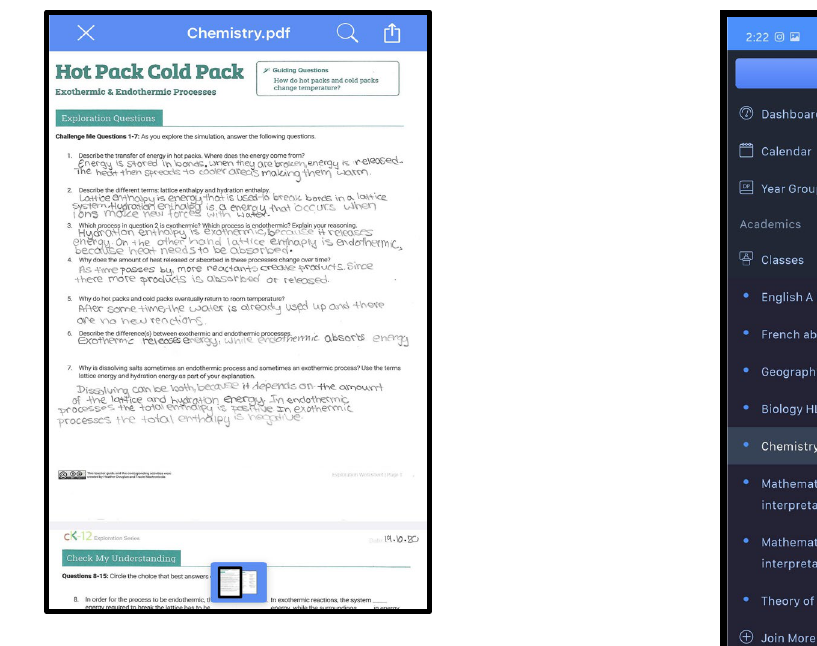
Figure 3e . A view of the students submission (teachers view)